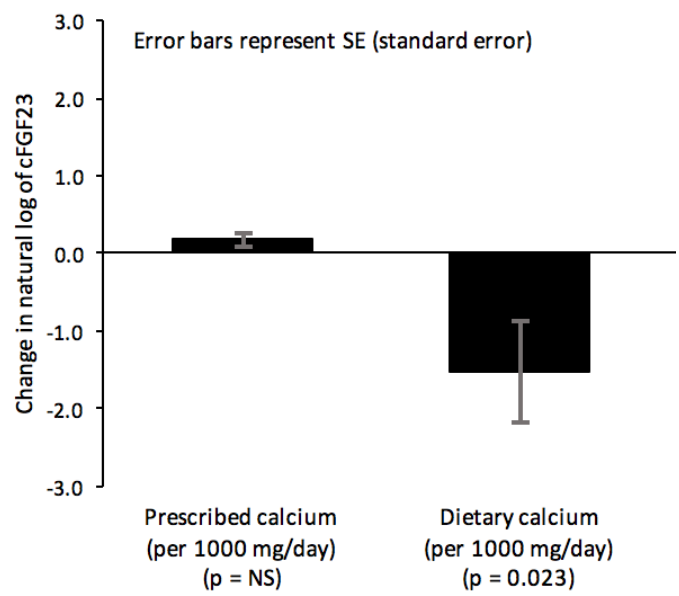
Figure 4. Changes in natural log of FGF23 as a function of sources of calcium.